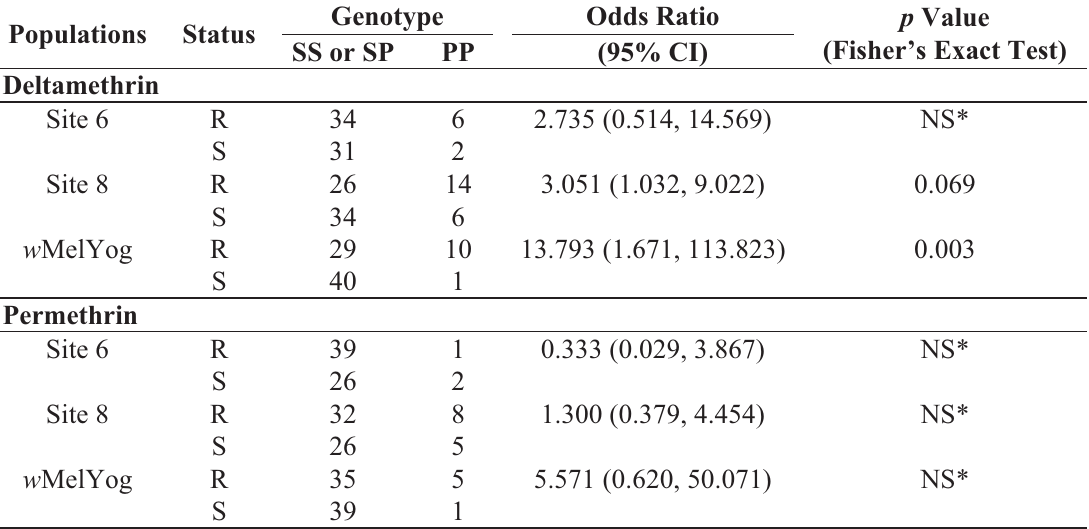
Table 9. Association between resistant and susceptible Vssc S996P alleles with mosquito susceptibility to permethrin and deltamethrin in